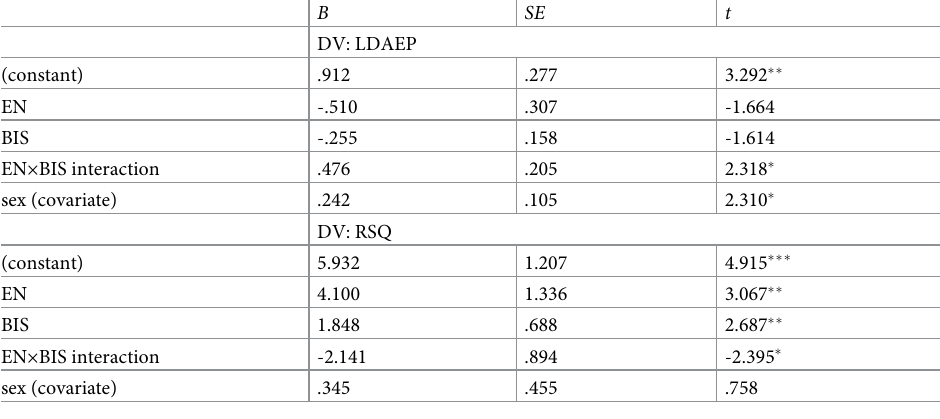
Table 2. Results of regression analyses of EN, BIS, and the interaction of EN and BIS on LDAEP and RS.